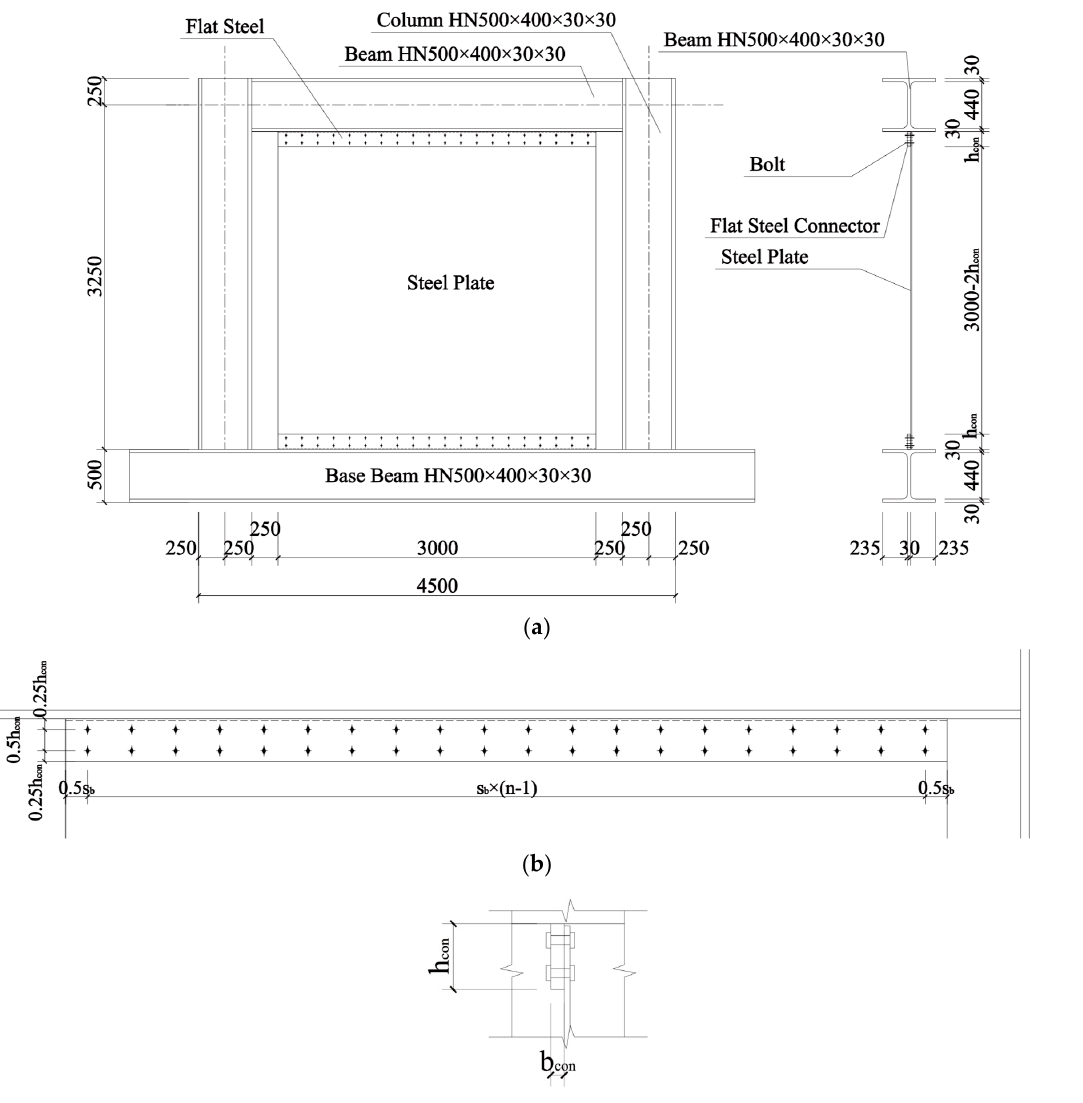
Figure 7. Sizes of FEM models for performance analysis. Table 5. Material properties of the components.